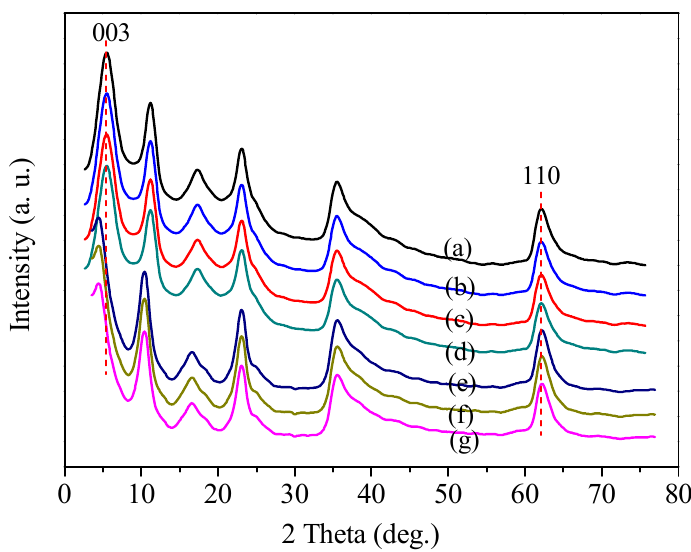
Figure 3. XRD patterns of ( a ) MgAl-LDH; ( b ) CuMgAl-LDH; ( c ) NiMgAl-LDH;